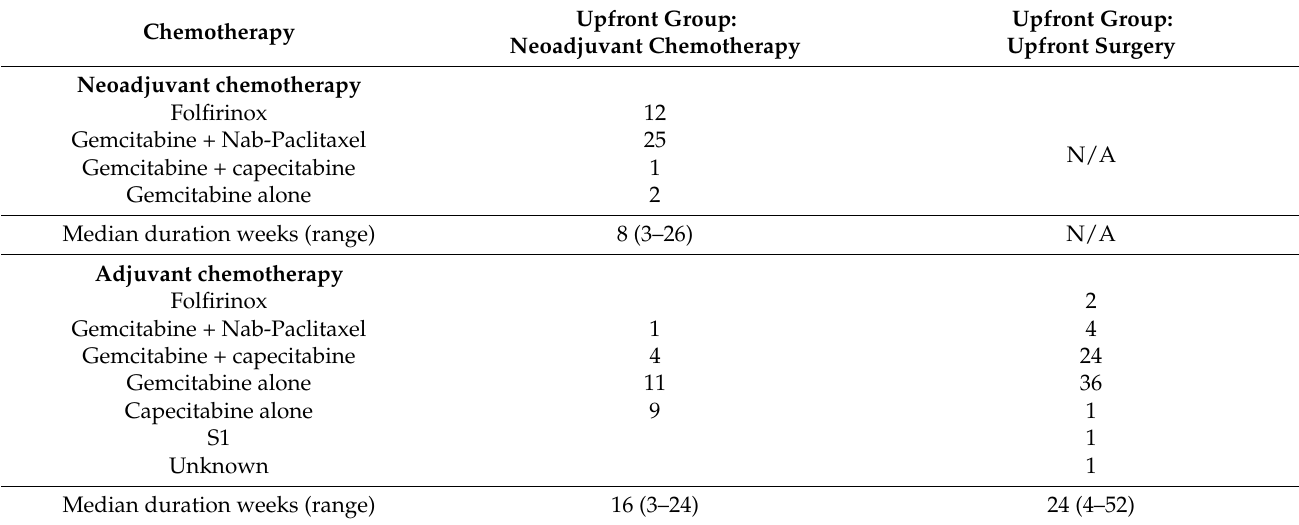
Table A1. Type and duration of neoadjuvant and adjuvant